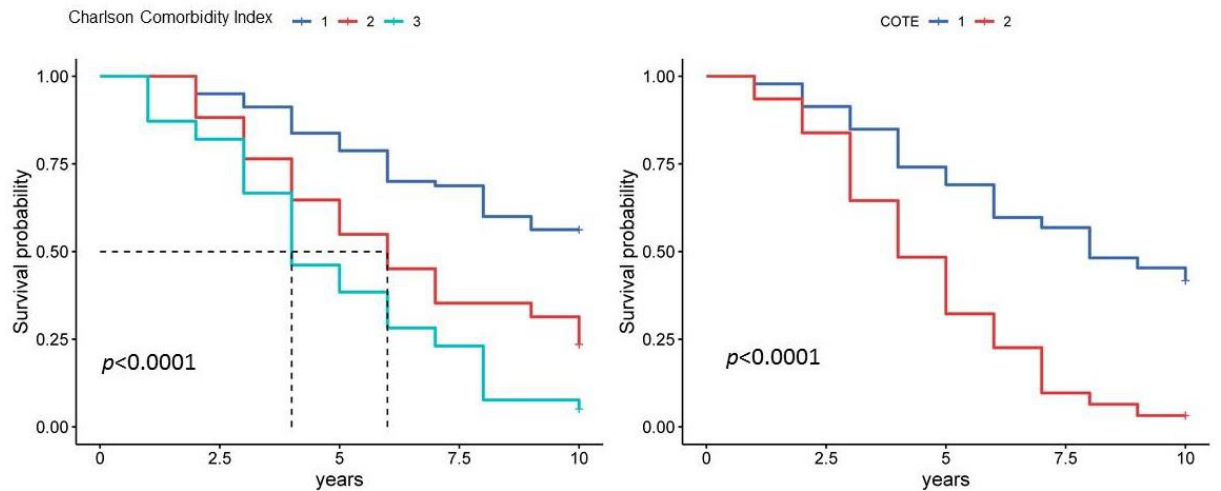
Figure 6. Kaplan–Meier curves for Charlson Comorbidity Index and COTE index in 10-year survival estimates. Notes: For the Charlson Comorbidity Index, subgroup 1 is a score of 1 to 4, subgroup 2 is a score of 5 to 6, and subgroup 3 is a score of 7 or higher. For the COTE index, subgroup 1 is a score of 0 to 2 and subgroup 2 is a score of 3 or higher.